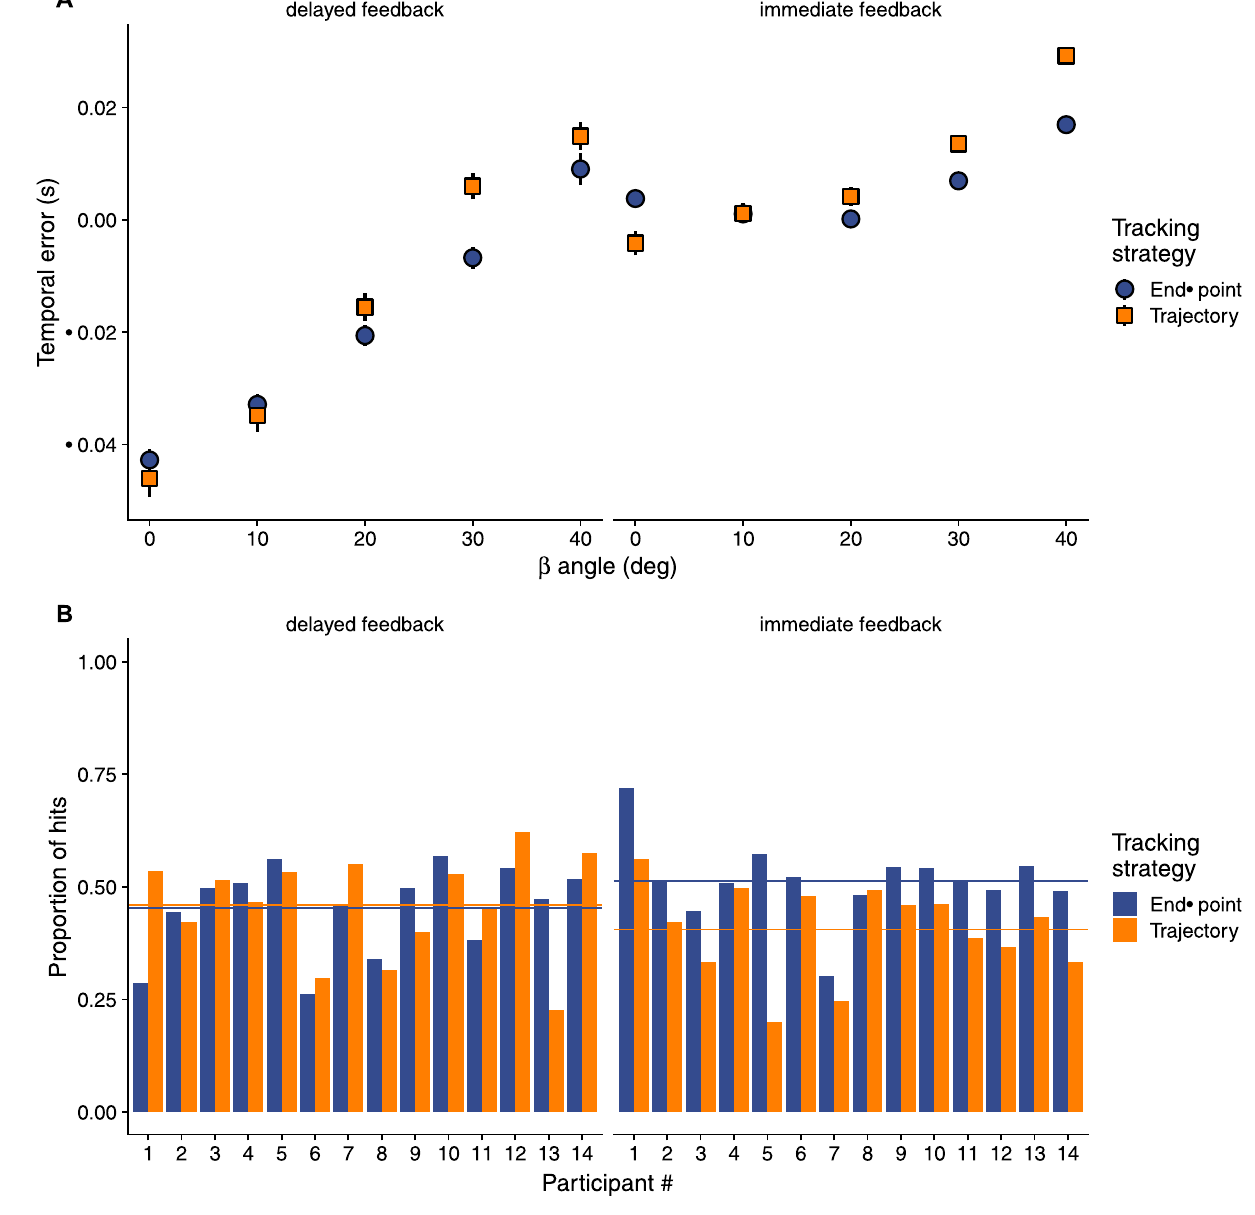
Figure 6. ( A ) Mean temporal error as a function of the angle of approach for the two conditions (in different panels) and split per tracking strategy (color and shape coded). Error bars denote 95%-CI. ( B ) Proportion of hits (a hit was scored whenever the target was intercepted while overlapping with the sphere representing the interception zone) per participant in the two feedback conditions (different panels) and split by the tracking strategy (color coded) in individual trials. The horizontal lines denote the mean proportions of hits across